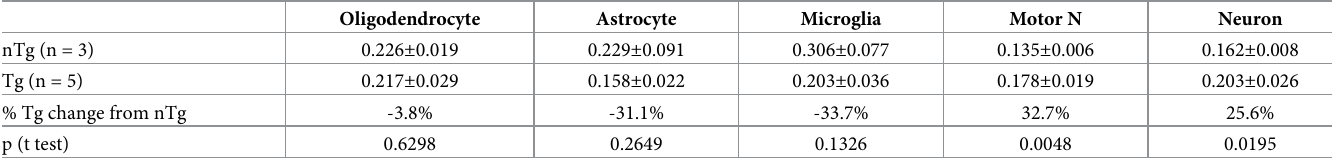
Table 1. Ratio of TDP-43 cytoplasmic levels to the nuclear levels.